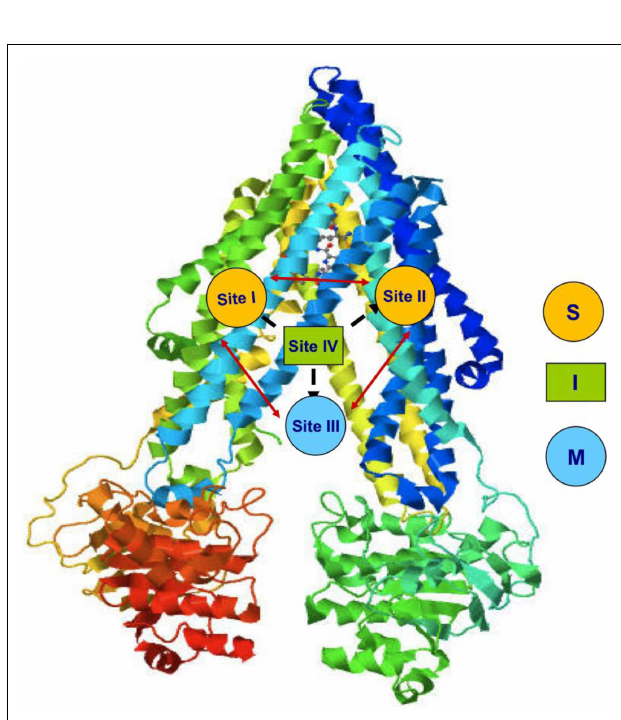
FIGURE 2 | P-gp binding sites (S: substrate, M: modulator, I: inhibitor